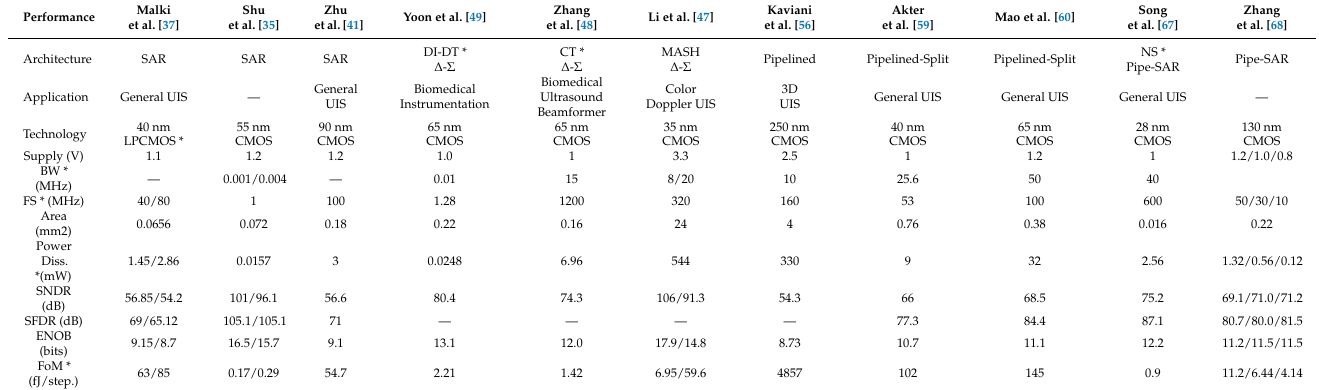
Table 1. Performance summary of the recently proposed ADCs for